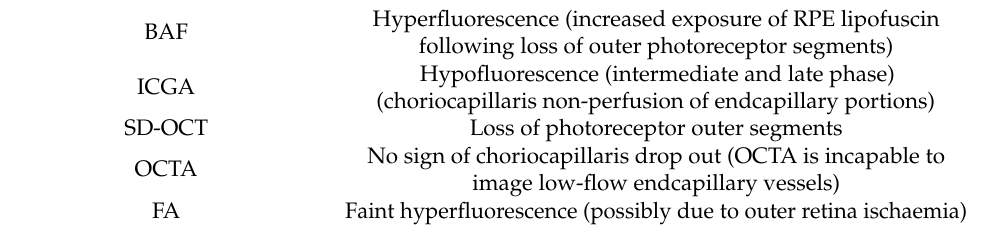
Table 2. Multimodal imaging of MEWDS lesions and clinicopathological